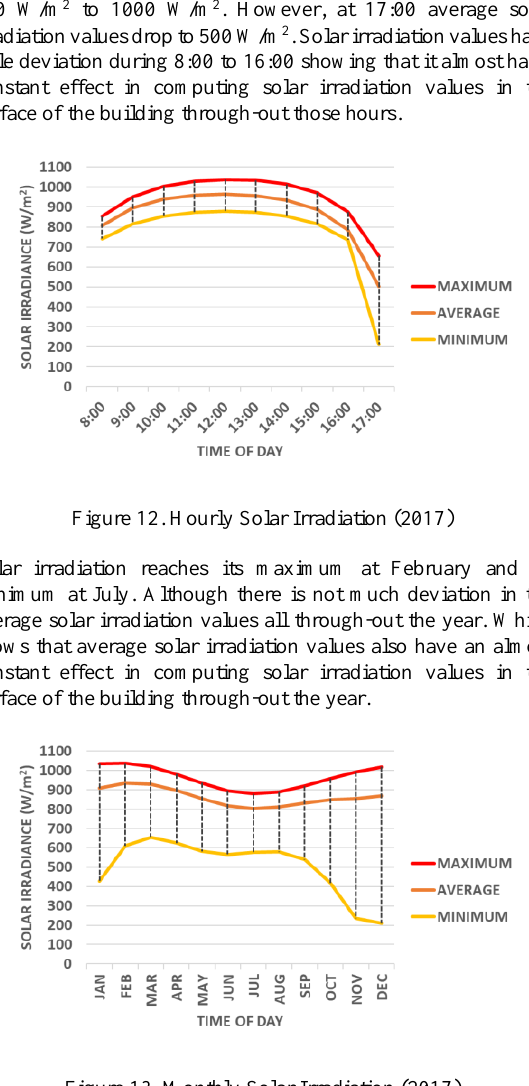
Figure 13. Monthly Solar Irradiation (2017)